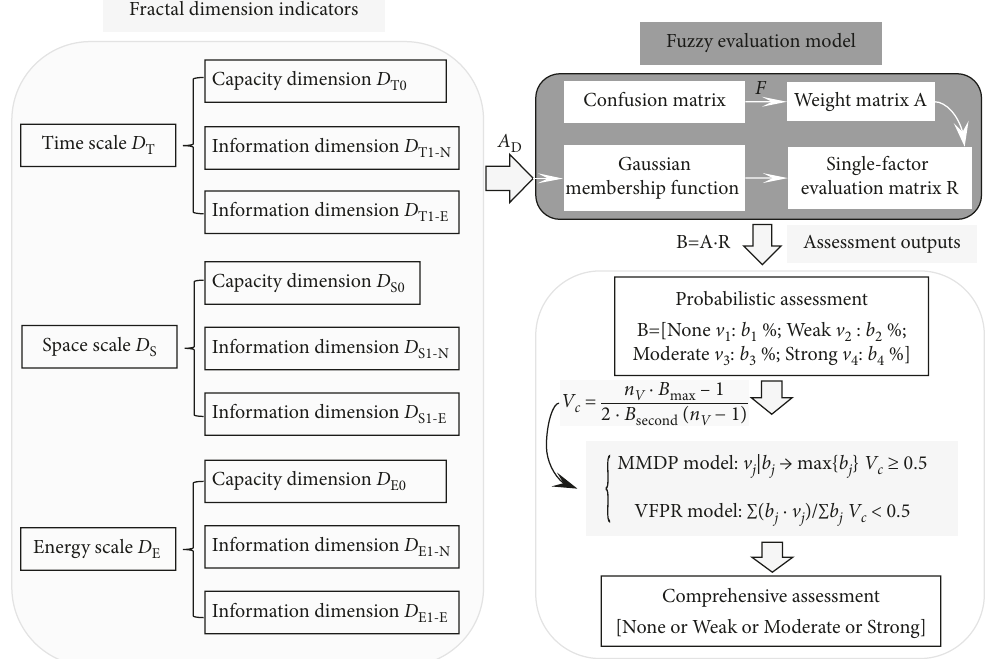
Figure 2: Framework of the fractal dimension-based methodology for the assessment of seismic hazards associated with rock failure using AE/MS monitoring data.